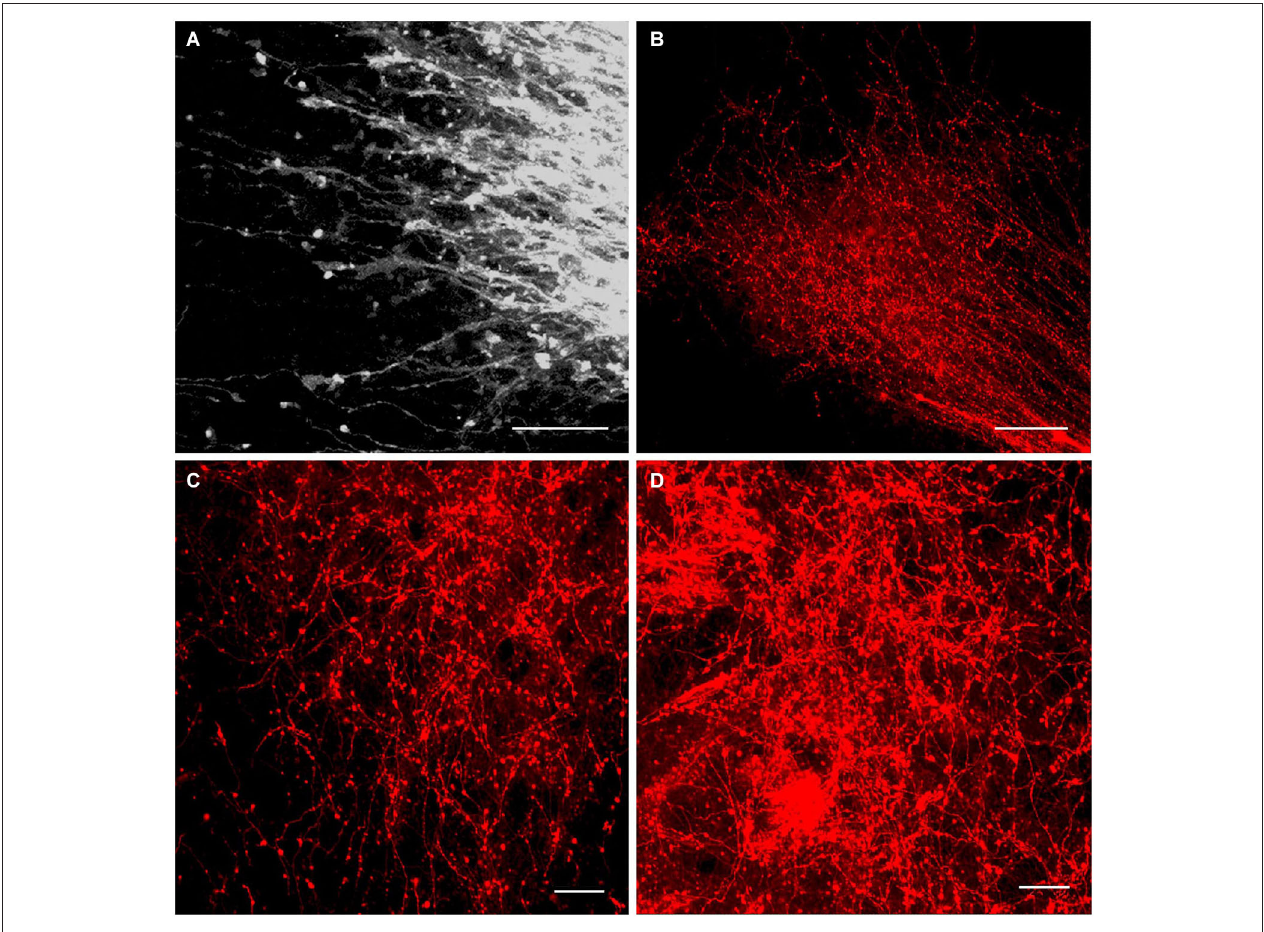
cones on the top of MTh. (B) P2, rostral end of the MTh growing into the anteromedial thalamic nucleus and forms terminal arborizations. (C) P4 and (D) P10, terminal network of the mammillary body axons in the anteromedial and anteroventral thalamic nuclei. Scale bars: (A,C,D) = 20 µ m, (B) = 80 µ